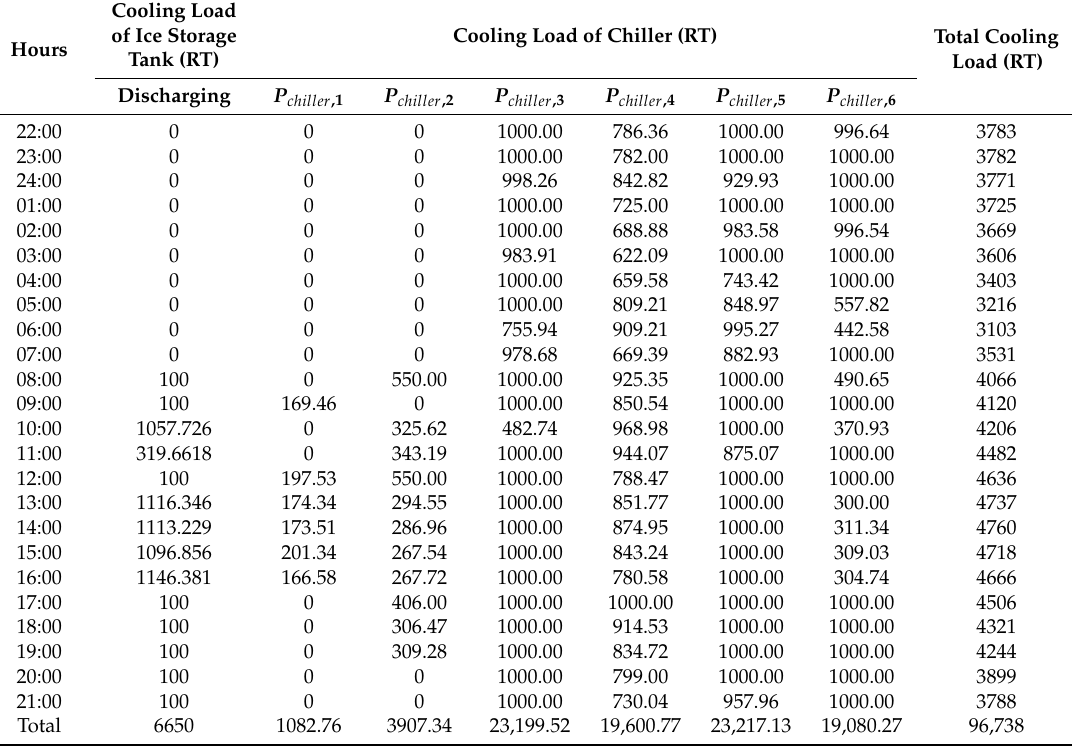
Table 6. The IRBSO for ice storage air conditioning of demand response.